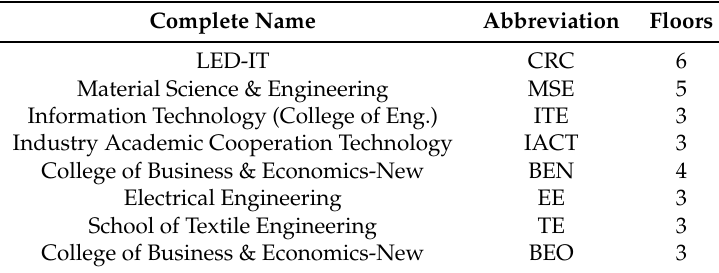
Table 2. Buildings’ description used in the experiment.